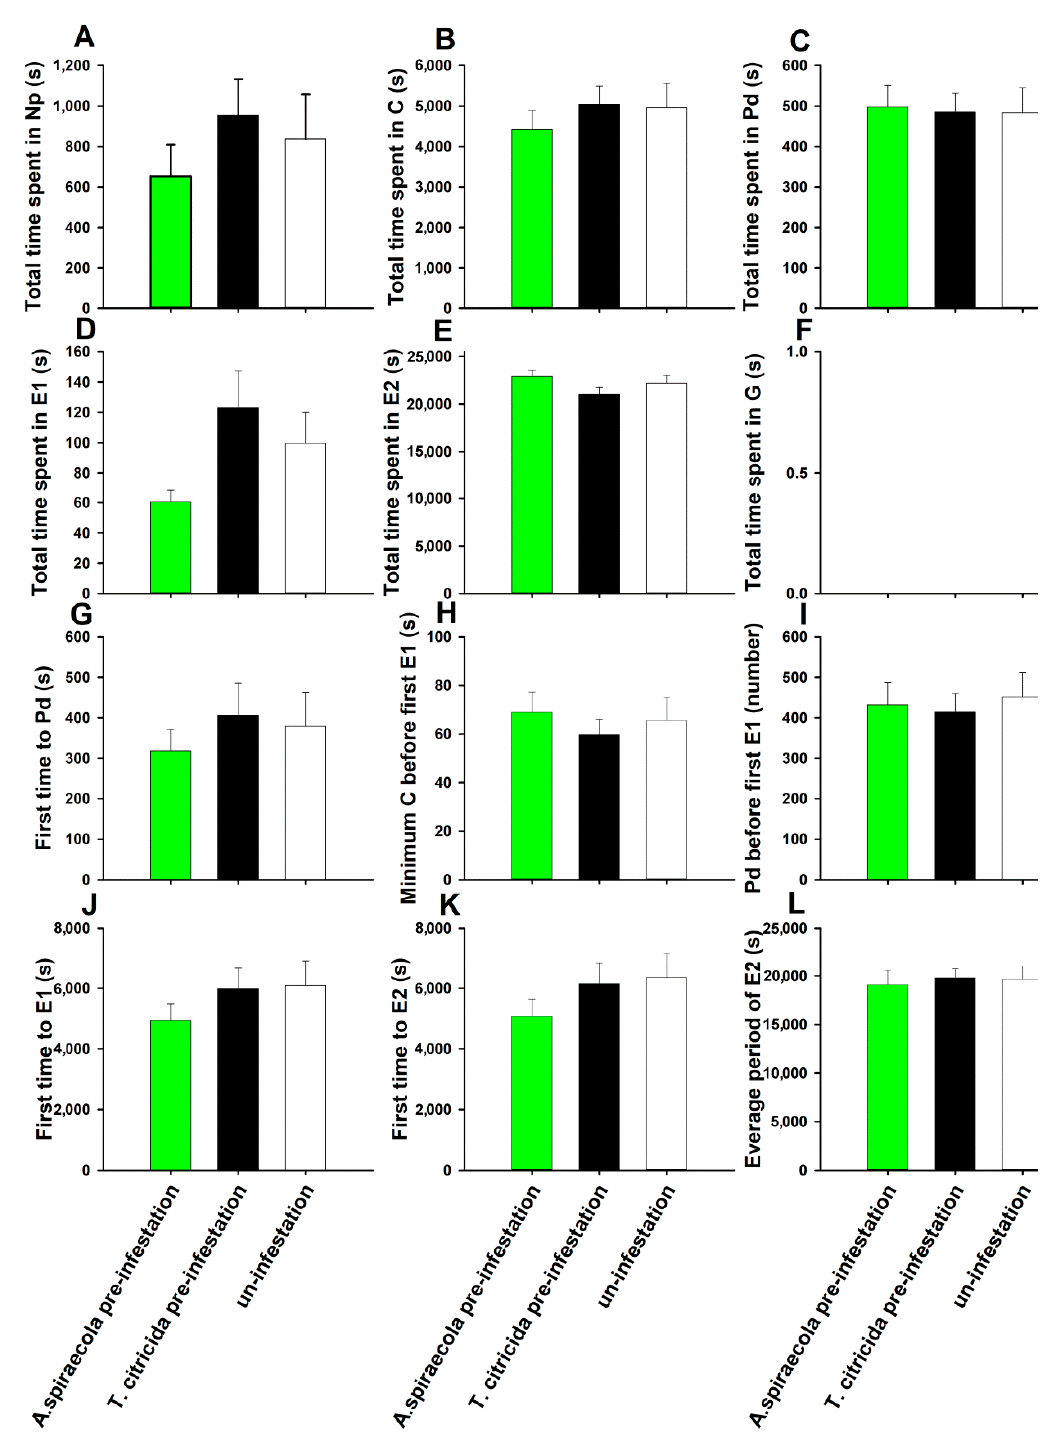
Figure 3. Effect of conspecfic and heterospecific pre-infestation on the feeding behavior of T. citricida . Values represent the mean ± SE (n = 19–23). Bars with different letters represent significant difference (Tukey’s HSD test, p < 0.05) in each waveform event. Bars without letters indicate there is no significant difference between treatments.